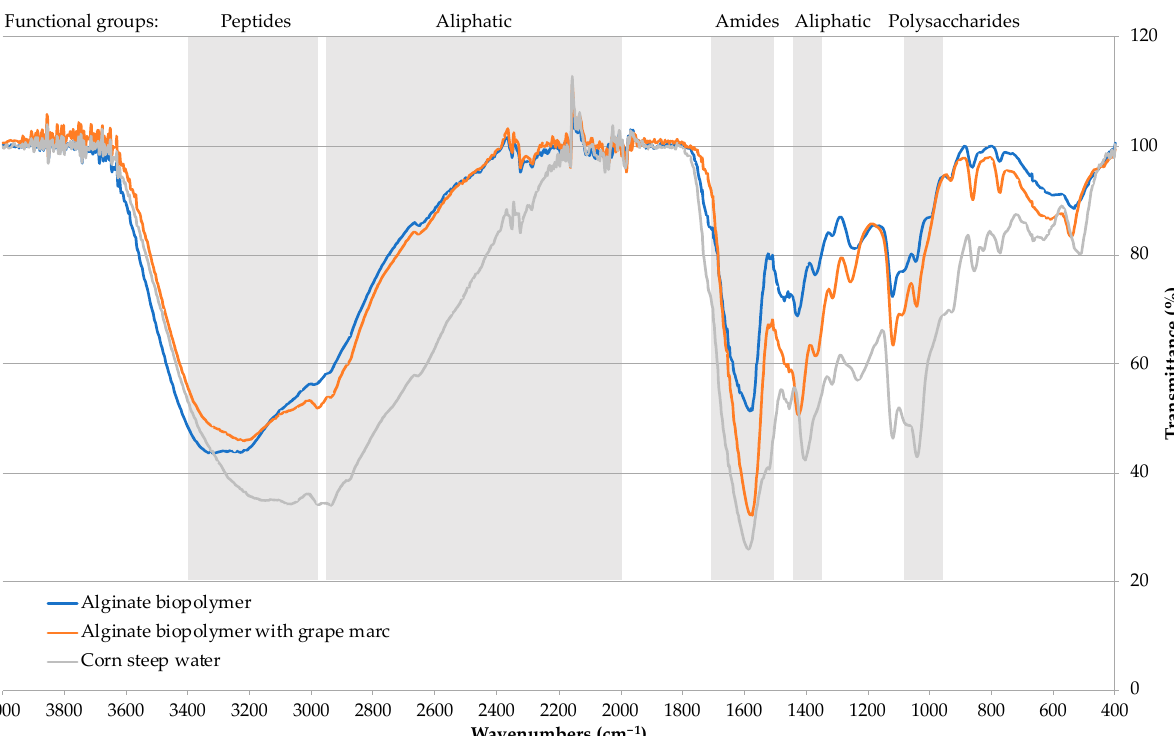
Figure 3. FTIR spectra of corn steep water before and after adsorption processes with calcium alginate-based biopolymers.